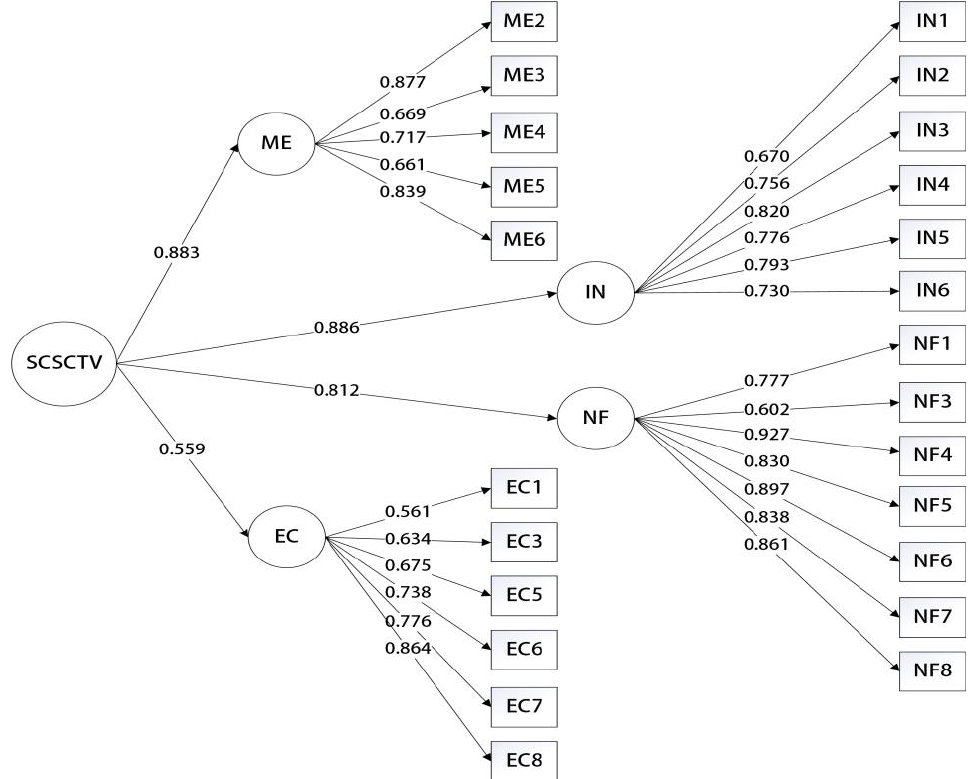
Figure 5. Factor loadings of the four-factor SCSCTV with 24 items.